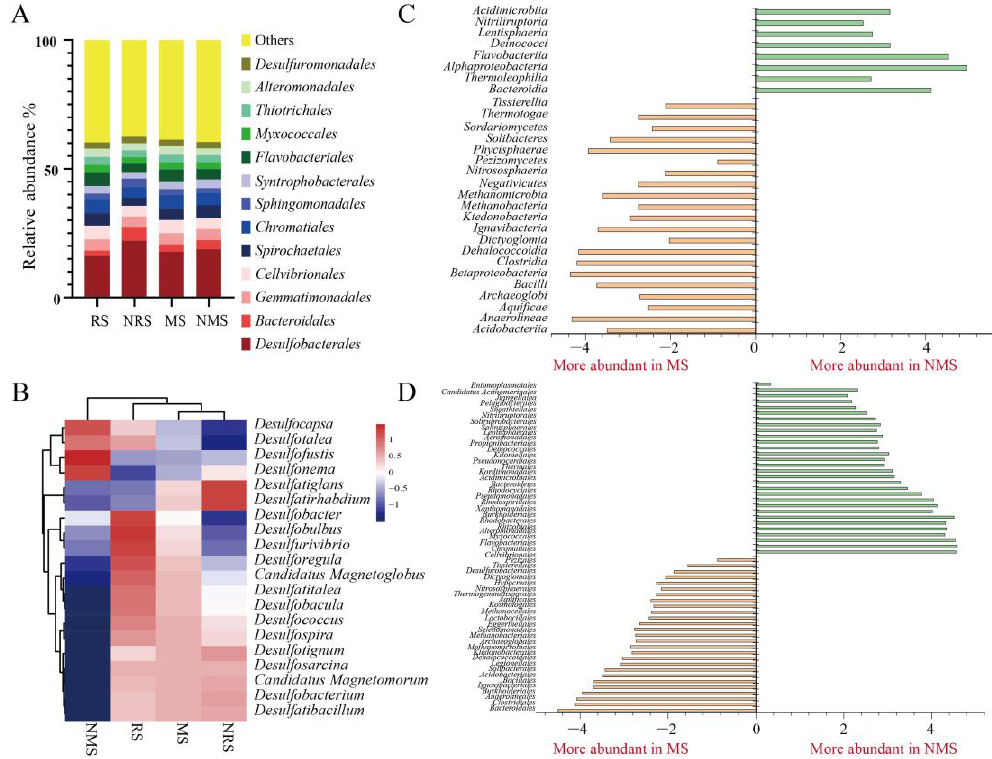
Figure 3. Comparison of taxonomic assignments from metagenomes. ( A ) Thirteen dominant orders with their relative abundance values (remaining orders indicated as “Others”). ( B ) Heat map of the Desulfobacterales order. Differential analyses between mangrove and non-mangrove regions at the ( C ) class and ( D ) order levels. For the differential analysis, the significance feature was selected using the Student’s t -test of p -values, and values are the base-10 logarithm of the abundance. Positive and negative values indicate taxa that are abundant in mangroves and non-mangroves, respec- tively.